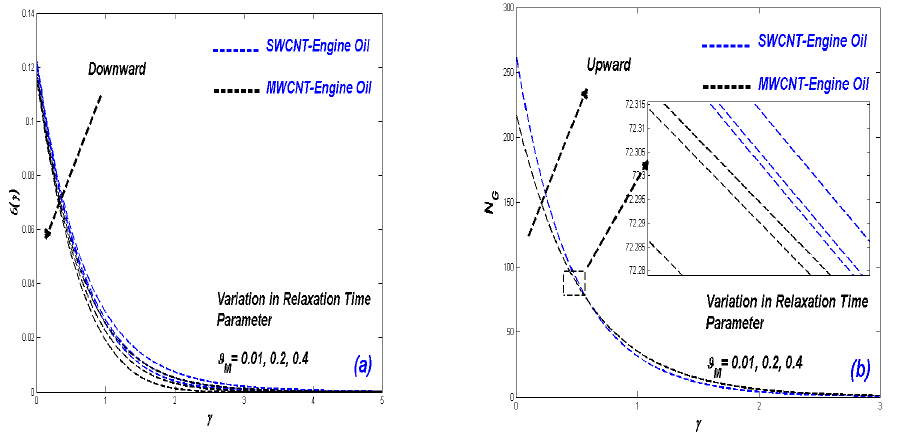
Figure 10. ( a ) Temperature change with ϑ M ; ( b ) Entropy change with ϑ M .